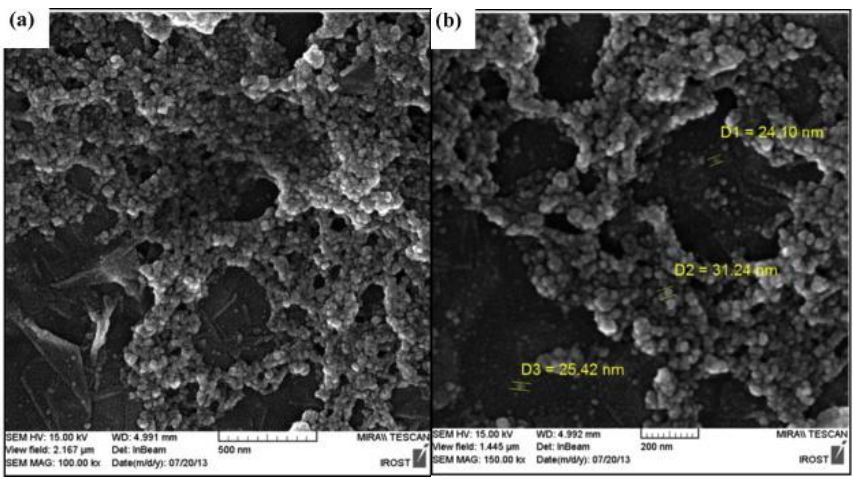
Figure 9. SEM images of magnetic chitosan nanoparticles. Reprinted with permission by Elsevier [114].